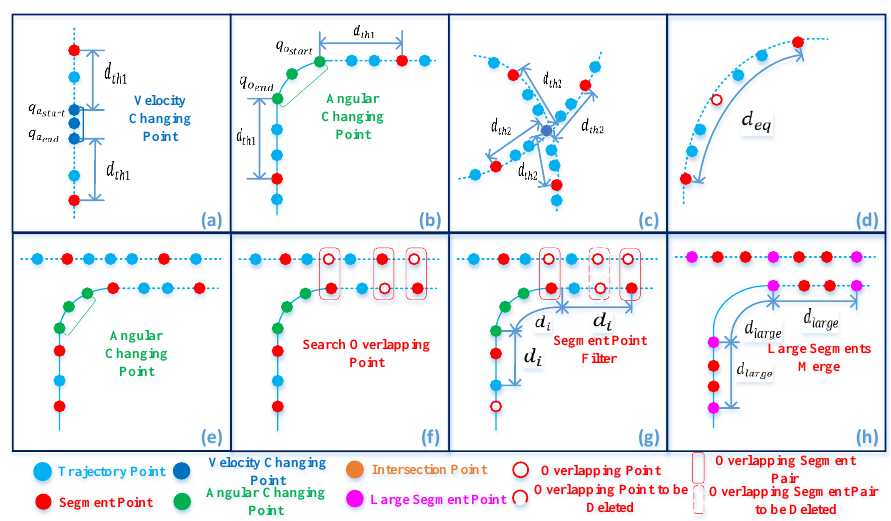
Figure 3. The pipeline of MLS point clouds partition. (a) find segment points by acceleration, (b) find segment points by angular velocity, (c) find segment points by intersections of vehicle trajectory, (d) insert new segment points if adjacent segment points are far away from each other, (e) candidate segment points, (f) find overlapping segment points, (g) filter candidate segment points, (h) obtain large segments by merging small